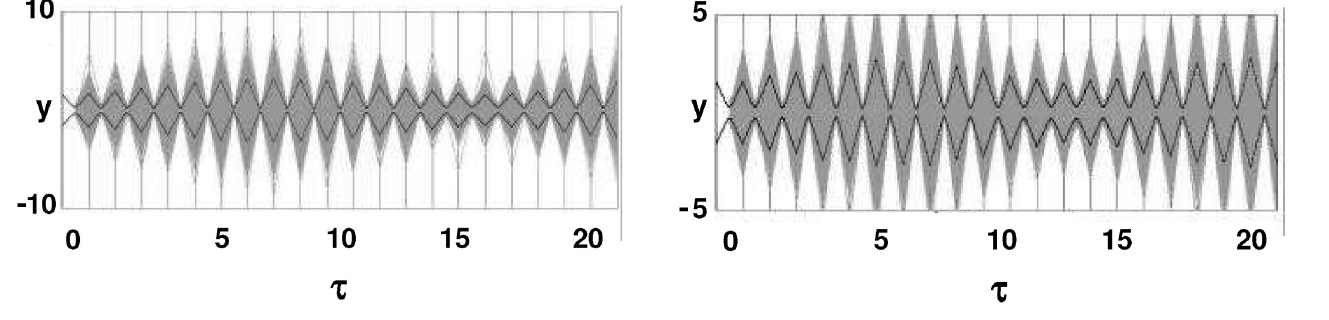
reflections.FIG. 4. Evolution of an optical beam in a resonator with z 0 : 1 and right mirror shift (cid:1) s (cid:2) 0 : 031 . The axes are the same as Fig. 2. The gray areas are the trajectories of 1000 random rays; the dotted lines, calculated from beam theory, correspond to the radius w of the Gaussian mode. The beam remains on axis, but expands and contracts with successive